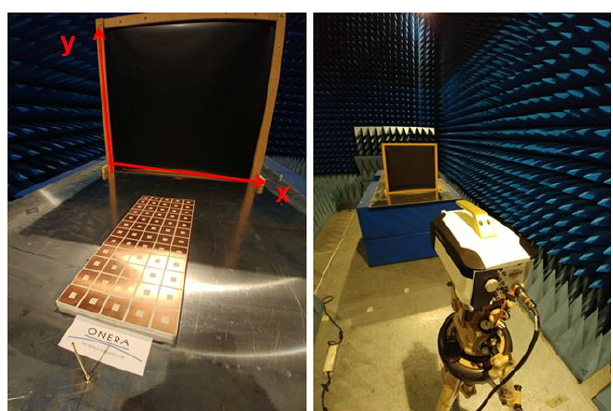
FIGURE 10. EMIR setup: ground plane, monopole, inductive metasurface, Kapton film, infrared camera